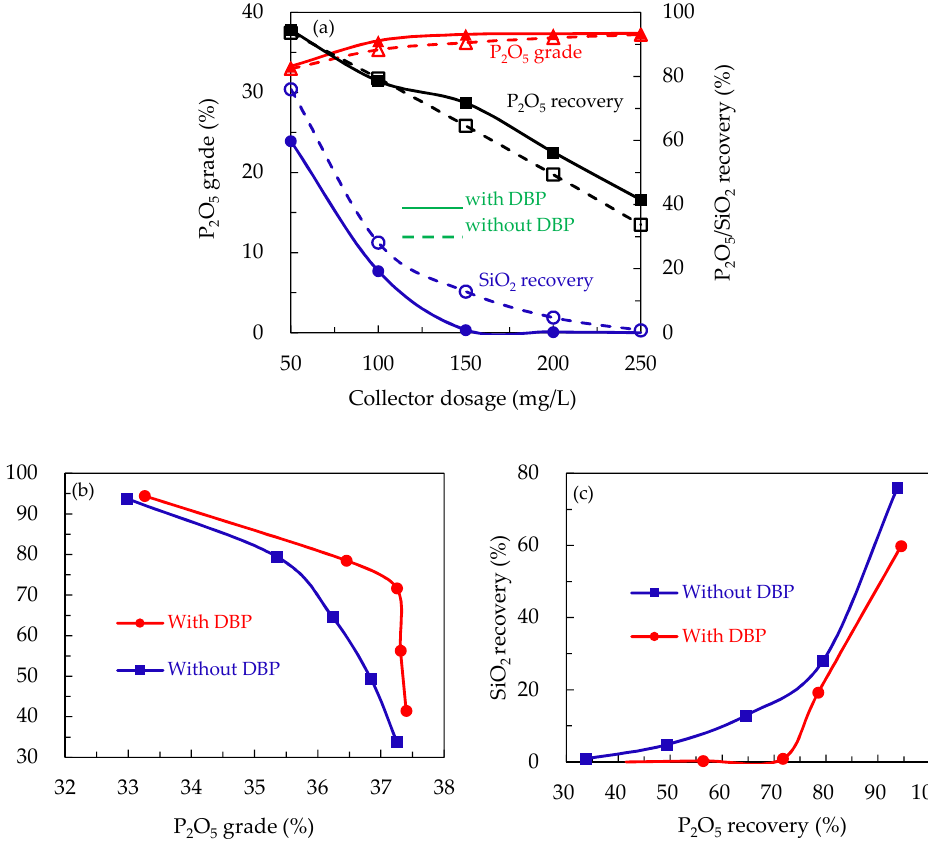
Figure 3. Effect of CTAB concentration on flotation performance of quartz and collophane mixture at pH 6.0. ( a ) P 2 O 5 grade, SiO 2 and P 2 O 5 recovery as a function of collector dosage with and without DBP; ( b ) P 2 O 5 recovery as a function of P 2 O 5 grade with and without DBP; ( c ) SiO 2 recovery as a function of P 2 O 5 recovery with and without DBP.